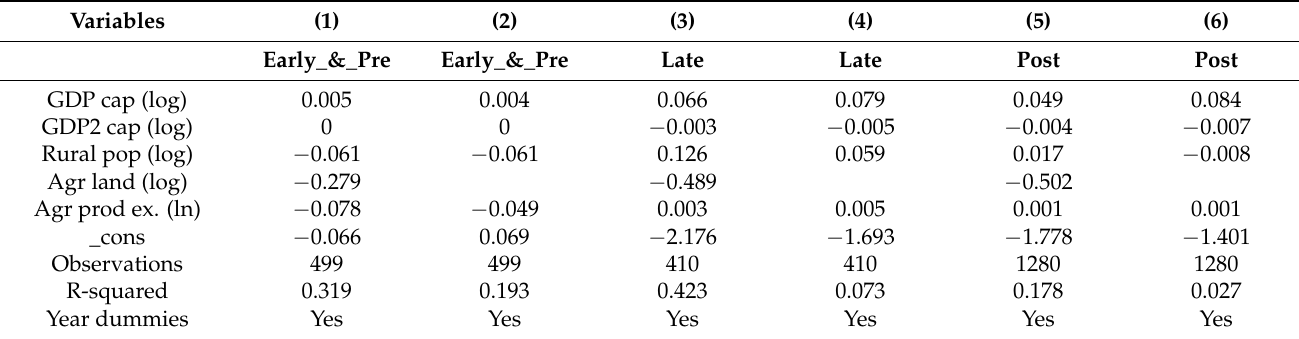
Table A8. Long run, forest transition clusters, net agricultural exports and net exports of forests products as additional control